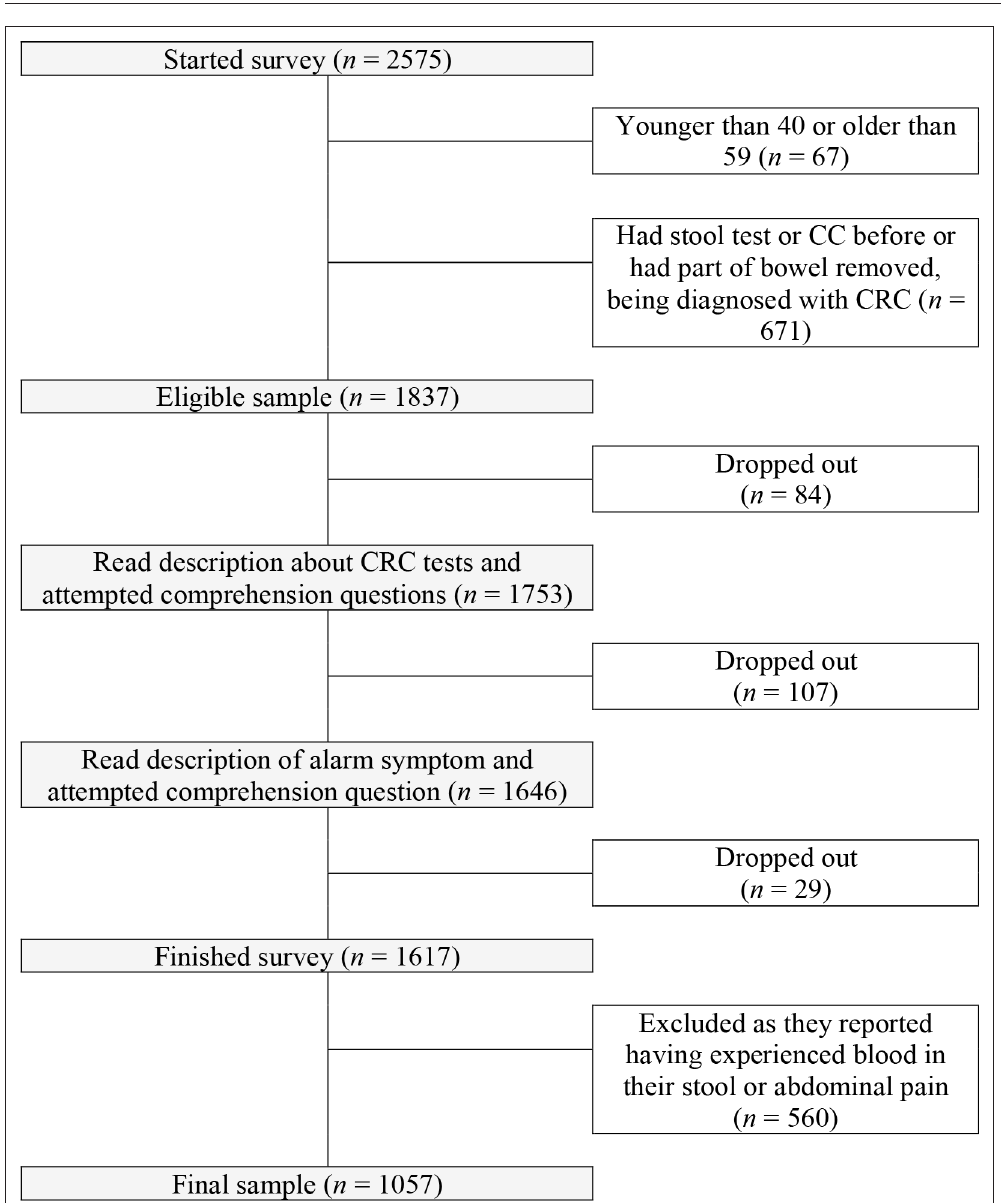
Figure 1 Flow through the